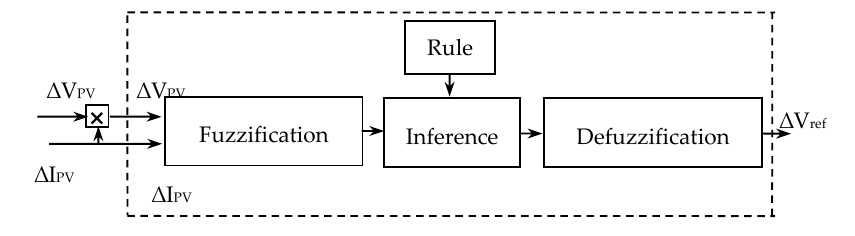
Figure 4. General diagram of a fuzzy logic controller.